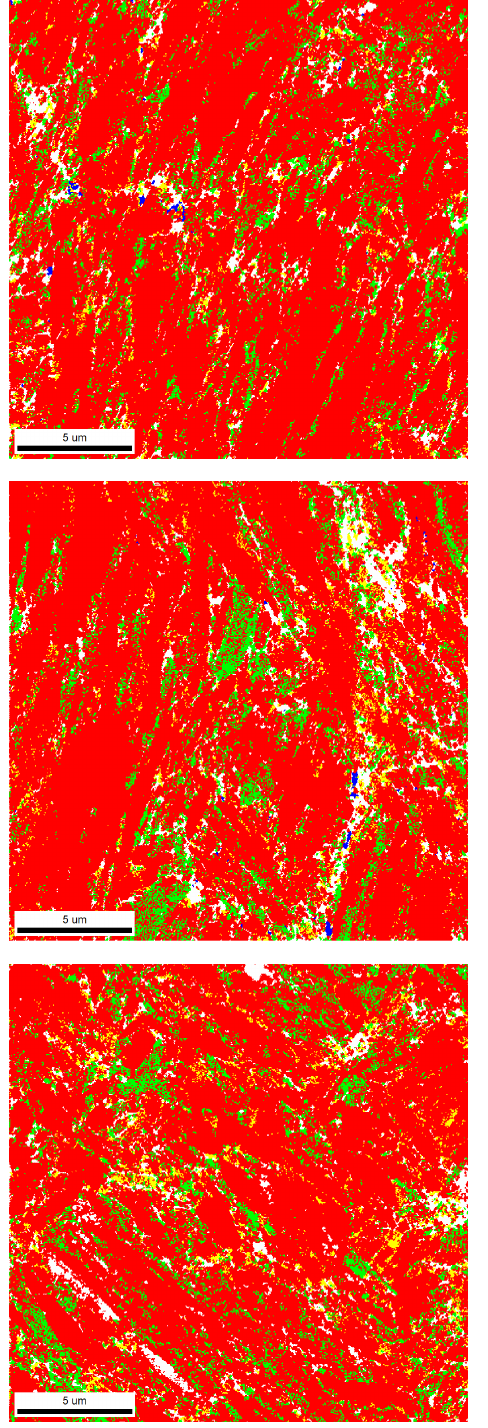
Figure 6. Effect of annealing on the microstructure C green, VC of the ferrite of the clad (upper as cladded, middle 23 6 after 550 ◦ C annealing for 2 h, bottom after 550 ◦ C annealing for 2+2